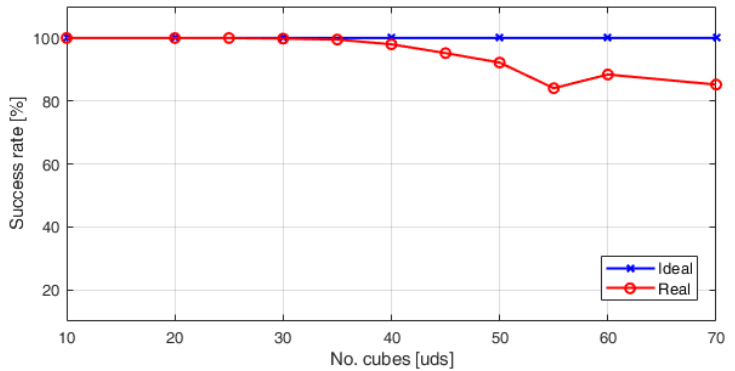
Figure 8. Success rate in cube counting in laboratory settings.